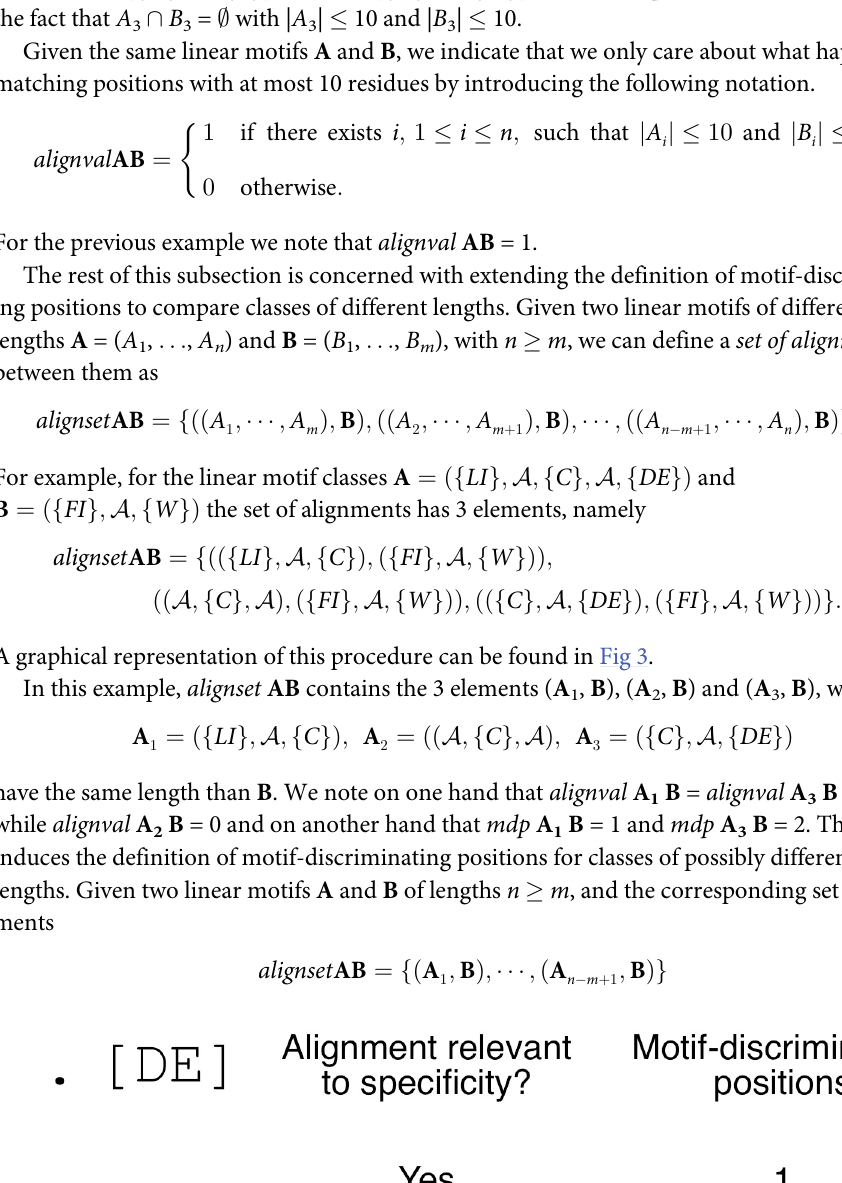
PLOS ONE | https://doi.org/10.1371/journal.pone.0248841 May 3,